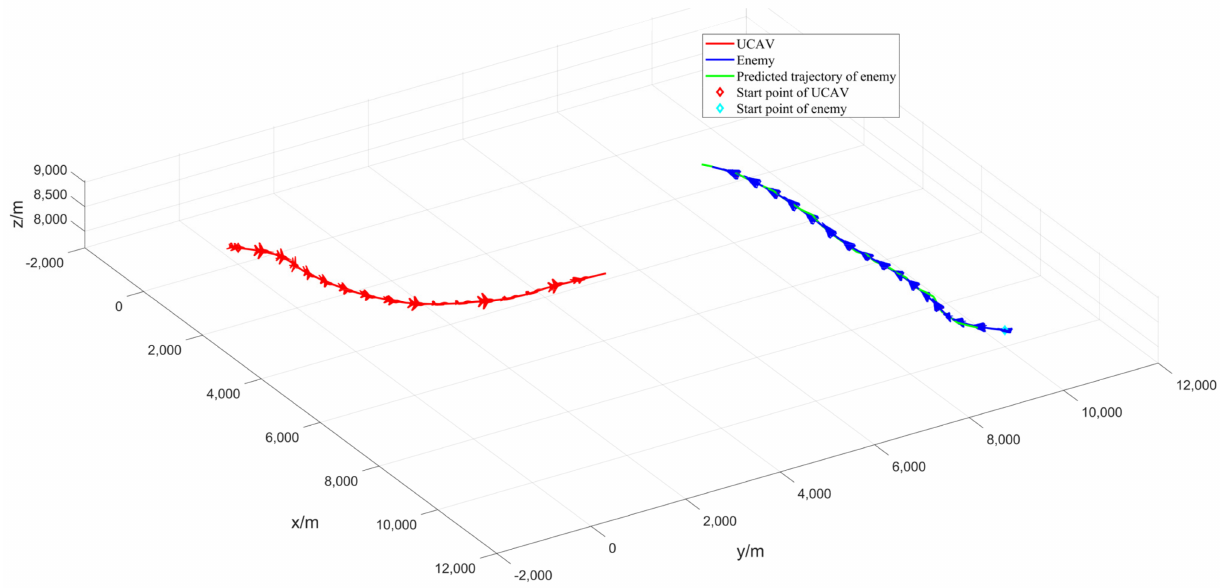
Figure 7. Three-dimensional air combat trajectory and predicted trajectory